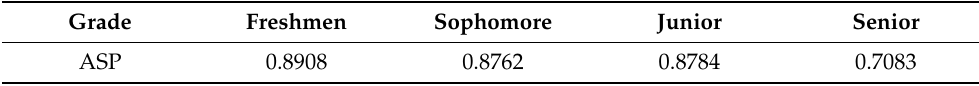
Table 4. Satisfaction ratio for different